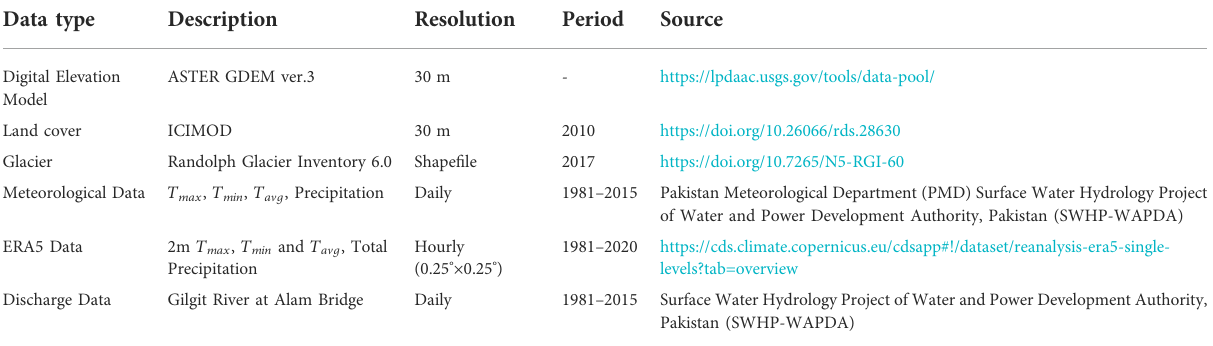
TABLE 1 List of datasets used in the current